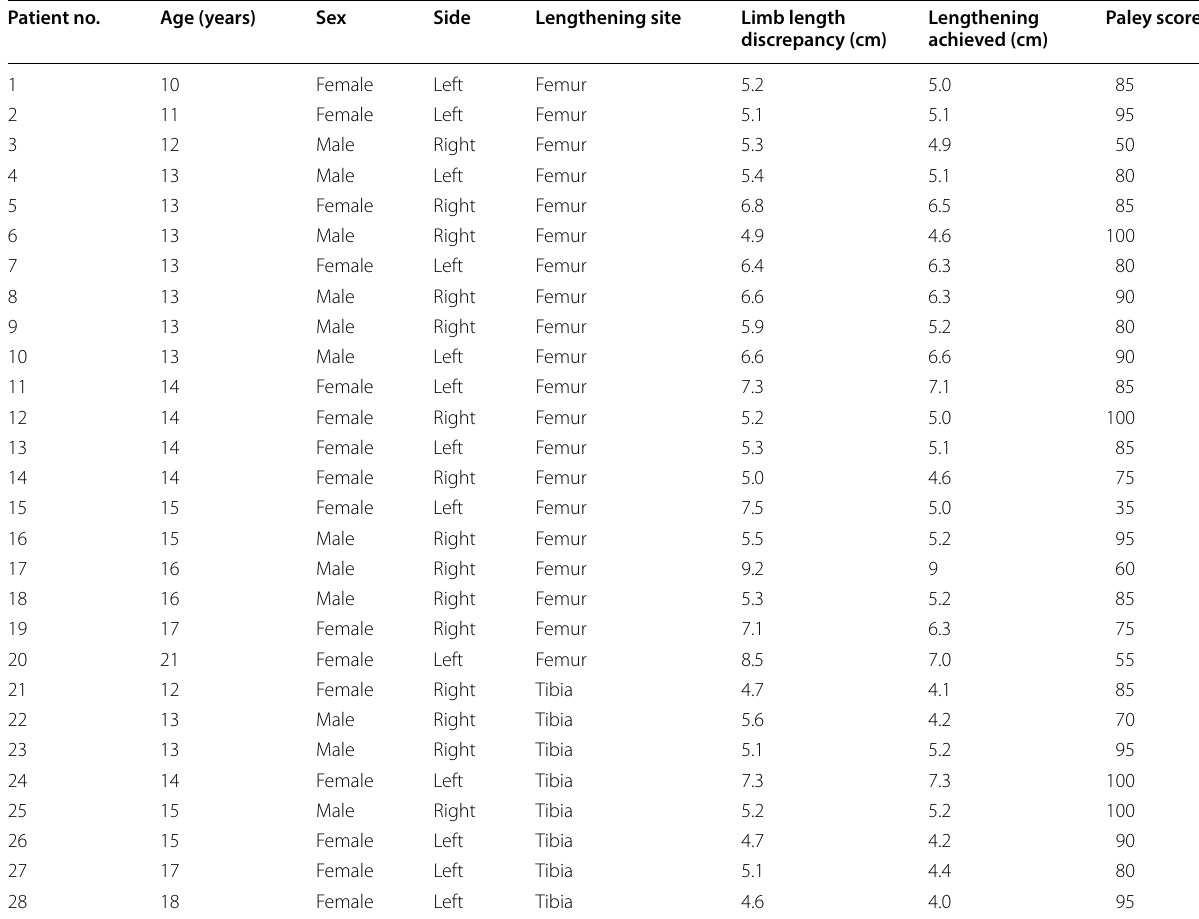
Table 1 Demographics and results of patients Patient